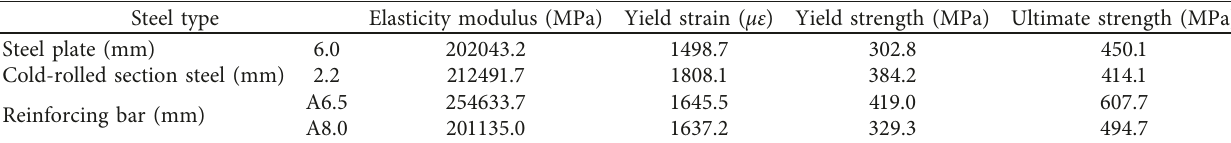
Table 3: Steel performance